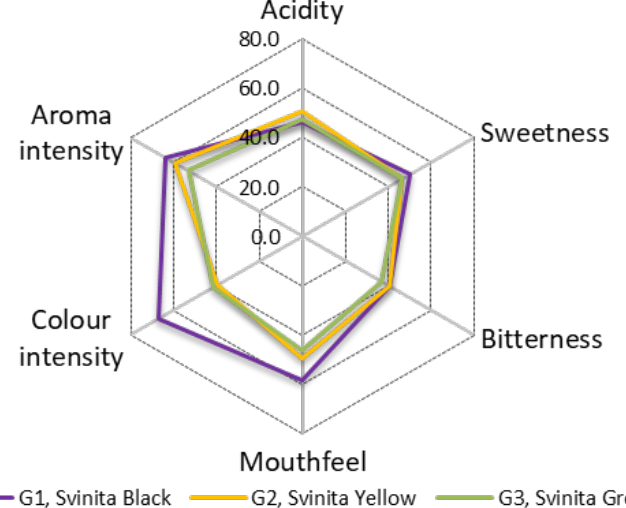
Figure 3. The average sensory profiles containing the main sensory characteristics of the alcoholic beverages fermented from three different fig varieties.